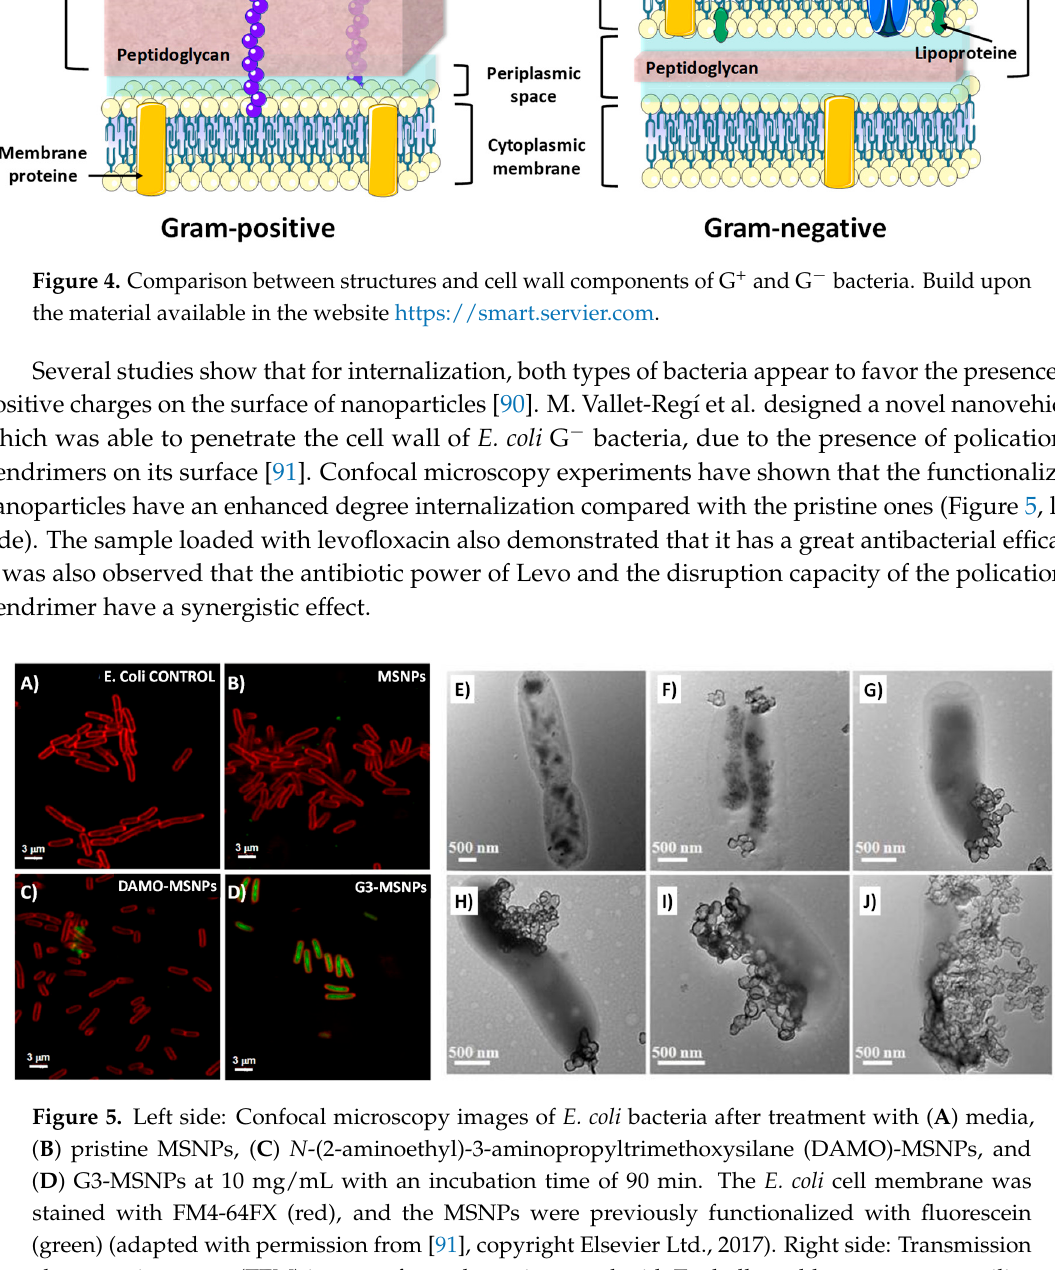
Figure 5. Left side: Confocal microscopy images of E. coli bacteria after treatment with ( A ) media, ( B ) pristine MSNPs, ( C ) N-(2-aminoethyl)-3-aminopropyltrimethoxysilane (DAMO)-MSNPs, and